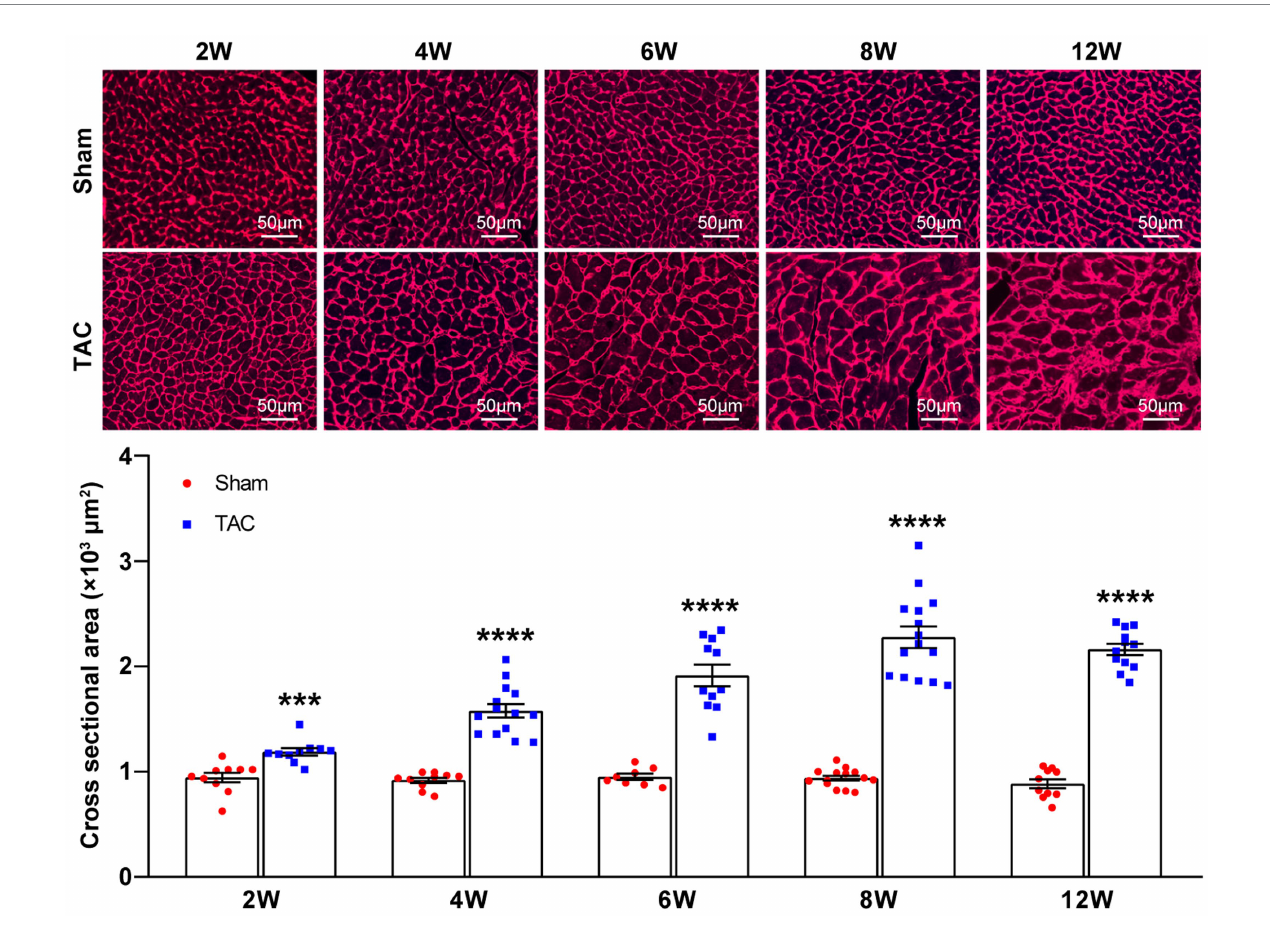
FIGURE 7 Cardiomyocyte area during TAC-induced time-series cardiac remodeling. Representative images of wheat germ agglutinin staining of heart sections (top). Quantification of cross-sectional areas of cardiomyocytes (bottom), n = 8~15. Unpaired t -test for two-group comparisons, *** p < 0.001, **** p < 0.0001 vs. corresponding